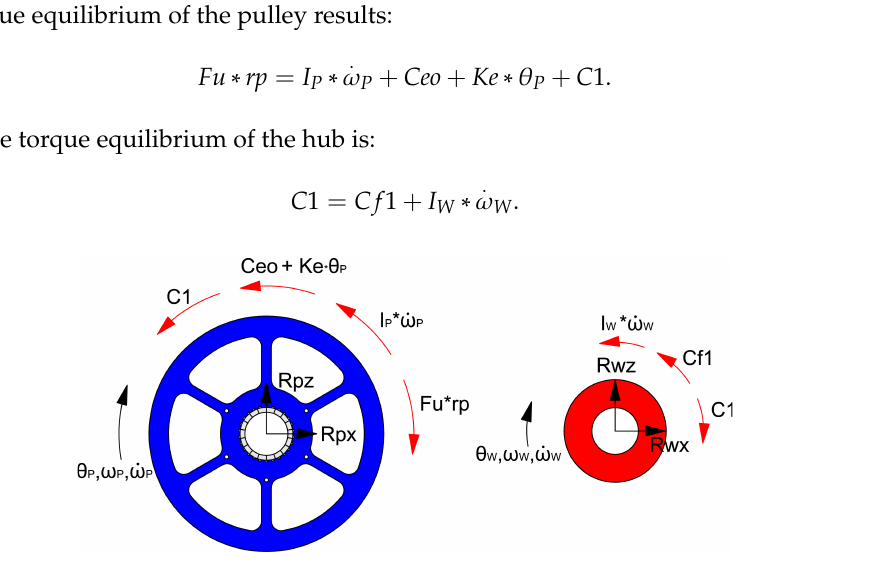
Figure 9. Free-body diagram during the traction phase.